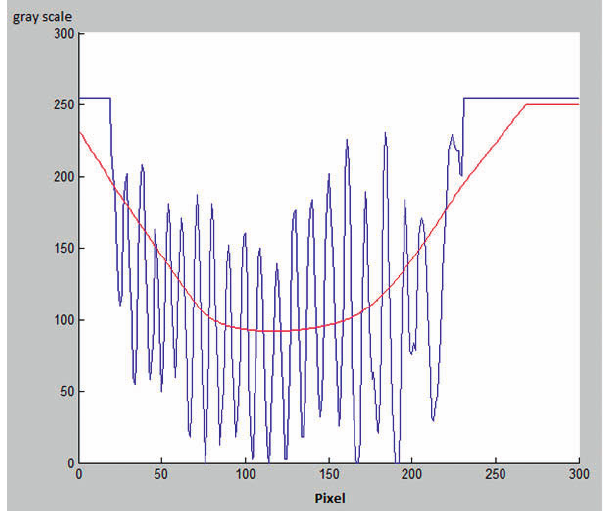
Figure 5. Thresholding a fingerprint strip by LOWESS.